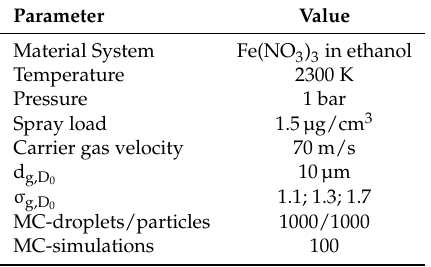
Table A1. Simulation